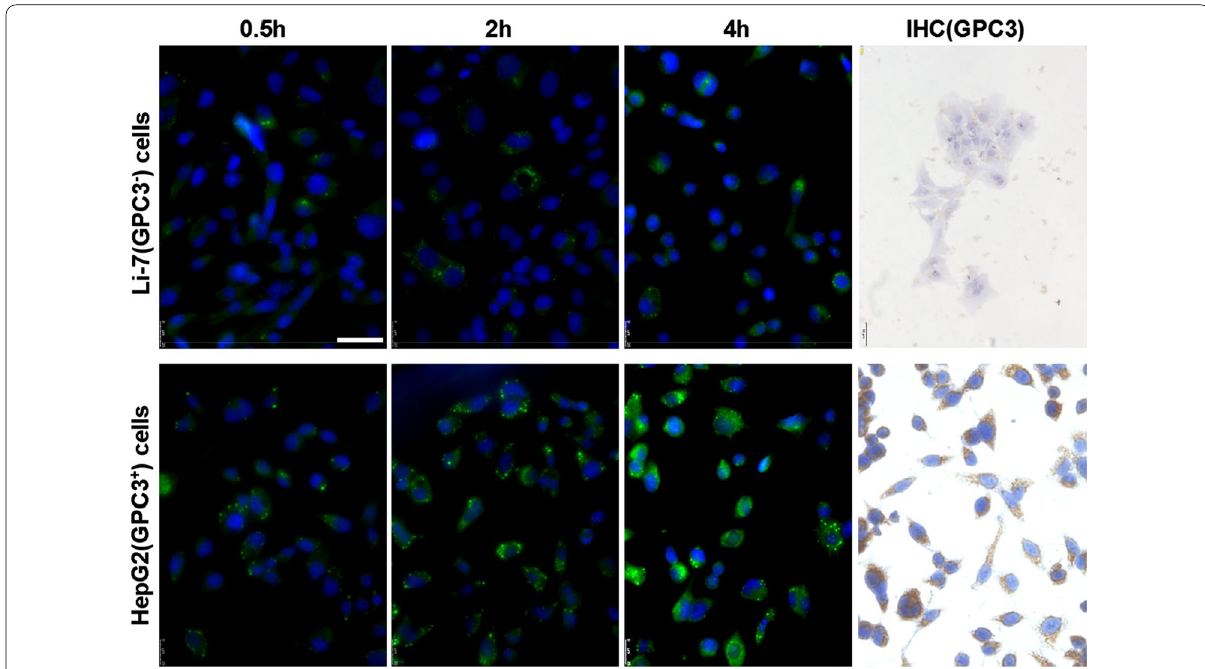
Fig. 2 Expression of GPC3 and uptake of hGC33-coumarin6-NP in Li-7 and HepG2 cells. The cells, inoculated in the culture plate, were washed with PBS and incubated with 100 μg/ml hGC33-coumarin6-NP in DMEM for 2, 4, and 8 h. Nuclei were stained with DAPI, and the cells were fixed and detected by confocal laser scanning microscopy. GPC3 was not detected in Li-7 cells, but was highly expressed in HepG2 cells as detected by immunocytochemistry. The scale bar indicates 50